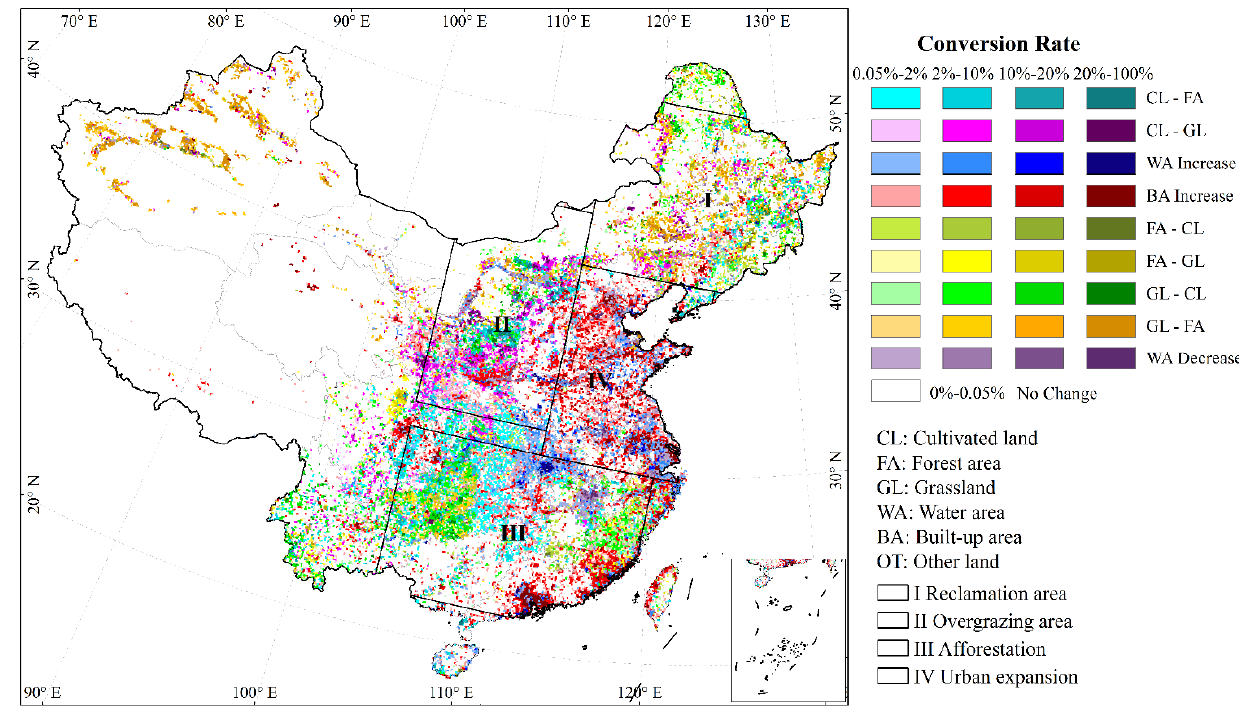
Figure 1. Main land use and land cover change in China,